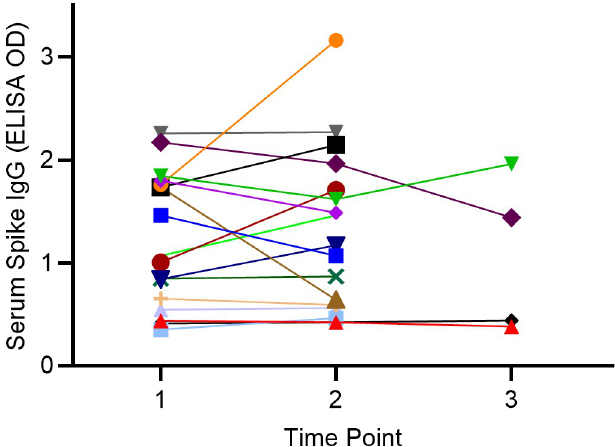
Fig 5. Longevity of serum SARS-CoV-2 spike IgG. The amount of spike antigen-specific IgG was measured based on the ELISA OD (Y-axis) over time (X-axis). Time point 1 = baseline, time point 2 = 6 weeks to 5 months, time point 3 = 7 months. Each different color symbol/line represents the mean of replicate data from a single time point for a single subject. The mean OD at time point 2 is not significantly different ( p > 0.05) from time point 1.